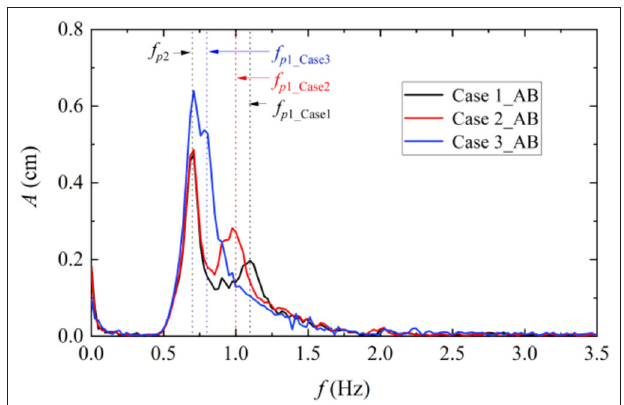
FIGURE 3 | Actual amplitude spectra at the location x = 5.0m for different peak frequently differences.